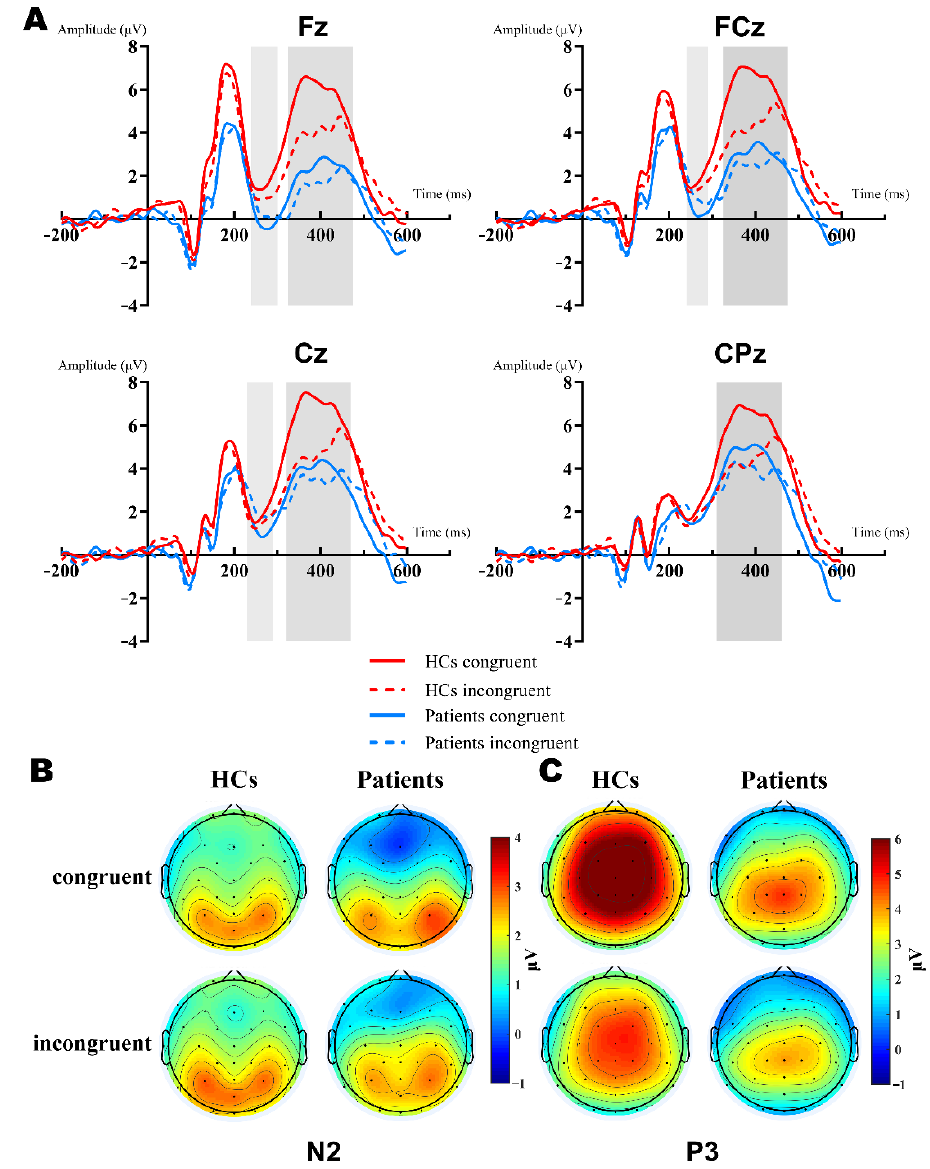
Figure 3. Grand-averaged ERP of the N2 and P3 waveforms and a topographic voltage map compari- son of the Fz, FCz, Cz, CPz sites by group. ( A ): Averaged N2 waveform comparison of the Fz, FCz, and Cz sites (light gray background). Averaged P3 waveform comparison of the Fz, FCz, Cz, and CPz sites (dark gray background). HC group: red lines; patient group: blue lines; congruent trials: solid lines; incongruent trials: dashed lines. ( B ): N2 topographies between groups and types. ( C ): P3 topographies between groups and